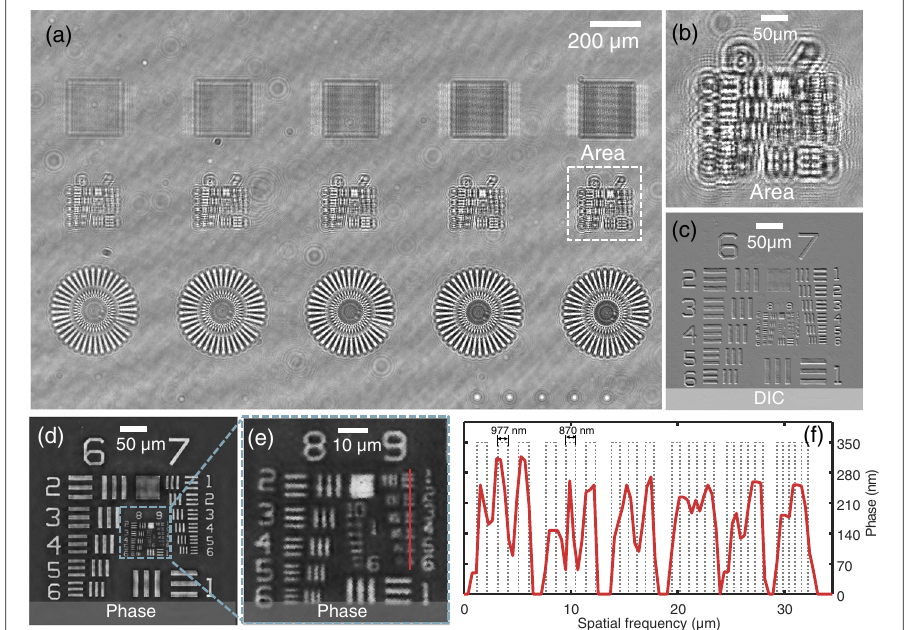
Fig. 28 Experiment for imaging verification by standard phase resolution targets QPT TM . (a) Original captured image. (b) The enlarged image of the sub-region of interest in original captured image. (c) Phase gradient image generated from reconstructed quantitative phases by digital DIC method. (d), (e) Reconstructed quantitative phase and the enlarged phase of the sub-region. (f) Quantitative phase profile along the red line in